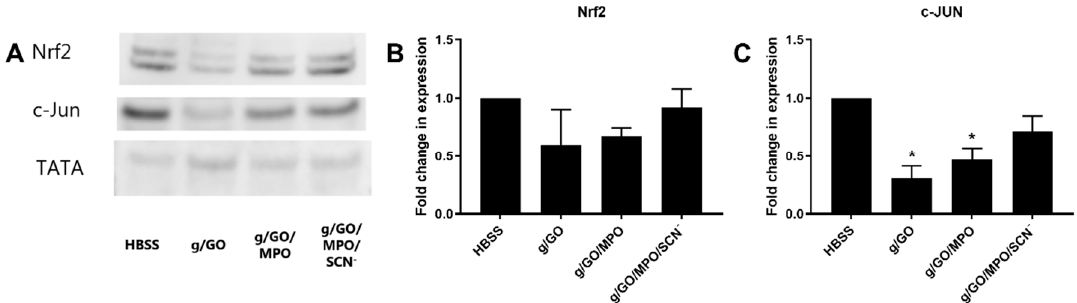
Figure 4. Exposure of J774A.1 cells to the GO/MPO enzymatic system suppressed the translocation of c-JUN. J774A.1 cells (2 × 10 6 ) were incubated in HBSS containing glucose (5.6 mM) (black bars), with GO (50 mU mL − 1 ), GO/MPO (50 nM), or GO/MPO/SCN − (200 µM) for 1 h at 37 °C before re-incubation in cell media for 24 h. The nuclear protein was extracted using a commercial kit and 10 µg protein was loaded. TATA was used as a loading control. Images are representative of three independent experiments ( A ). Panels B and C show the densitometry analysis of Nrf2 ( B ) and c-JUN ( C ) following normalization to TATA. Data are expressed as the fold change compared to the respective non-treated group. * shows a significant difference ( p < 0.05) compared to the non-treated control groups by 1- way ANOVA with a Dunnett’s multiple comparison test.